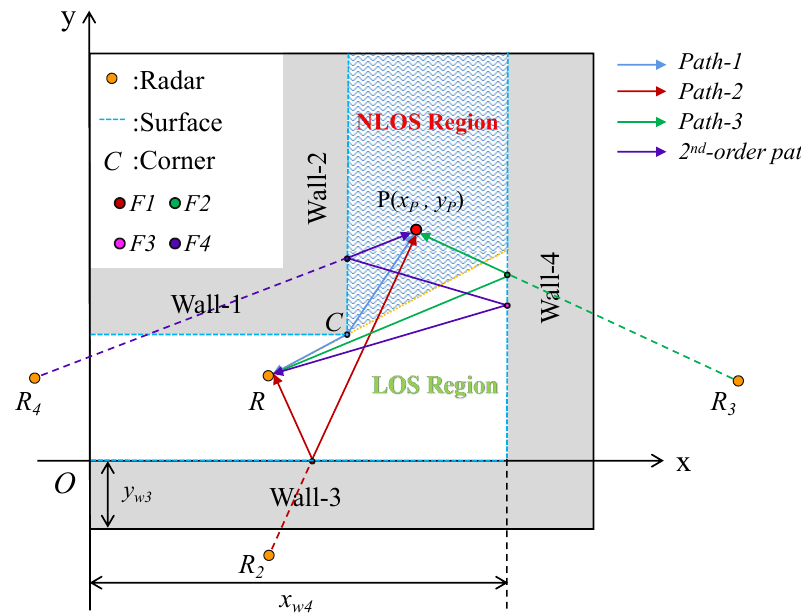
Figure 1. Multipath propagation model in L-shaped corner